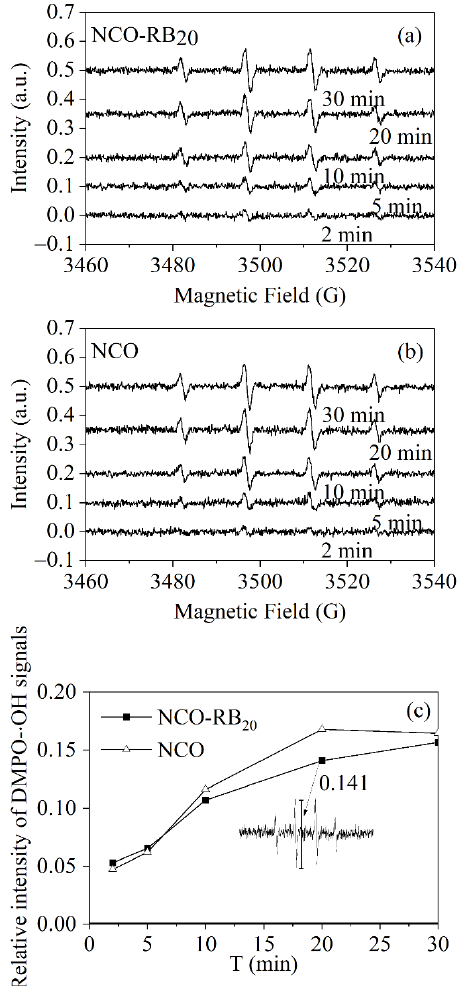
Figure 7. Electron paramagnetic resonance (EPR) spectra of · OH in NCO-RB 20 /air system ( a ) and NCO/air system ( b ); the corresponding relative intensity of DMPO- · OH signals in NCO-RB 20 /air and NCO/air system ( c ).